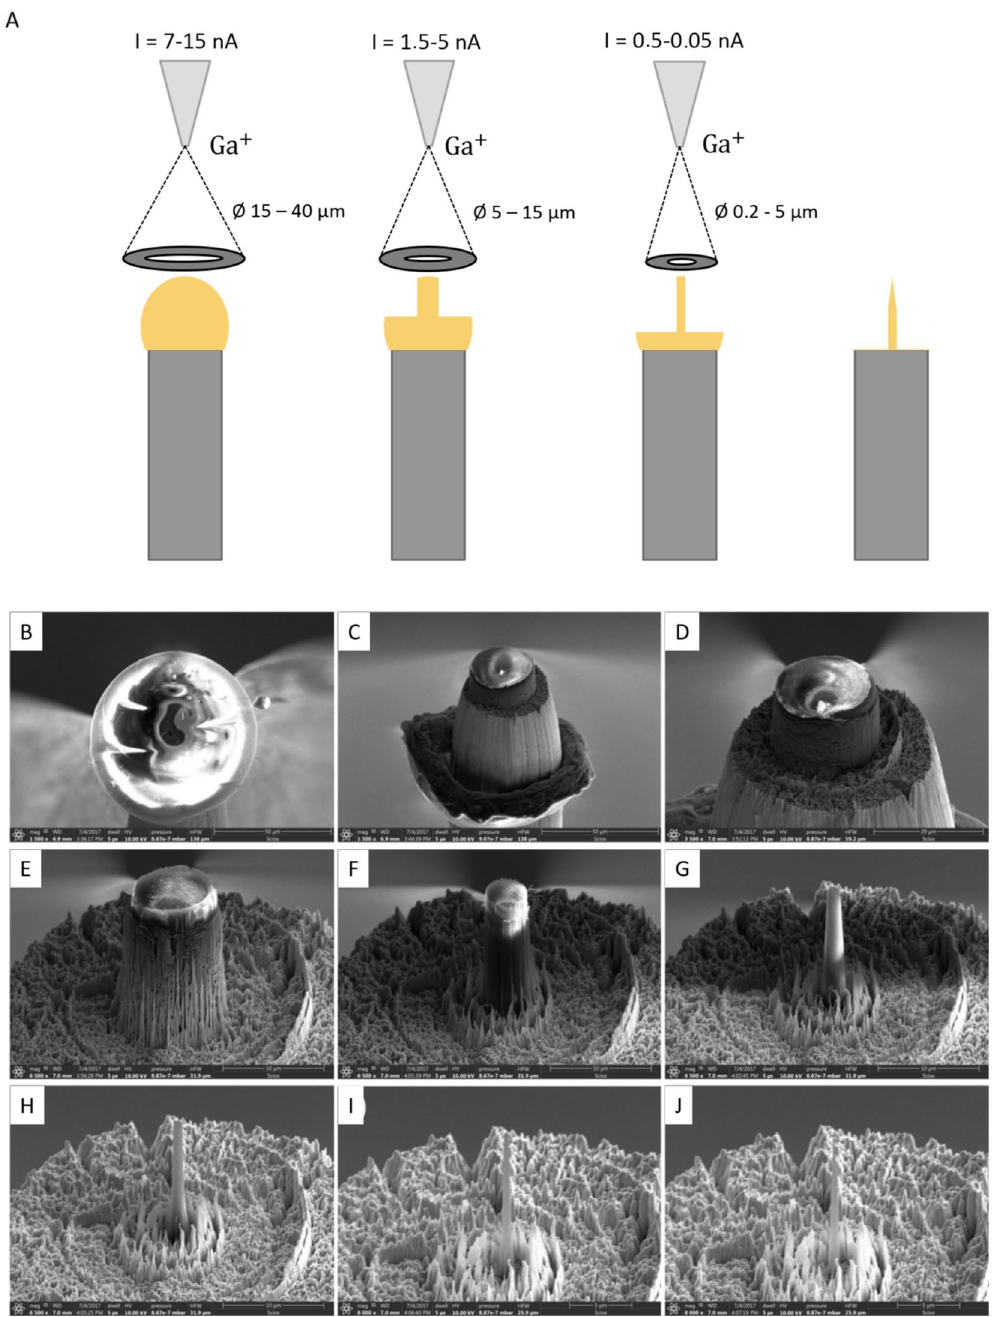
Figure 9. FIB Preparation—above in ( A ) the annular milling process with a decreasing inner diameter and respective current is schematically shown. ( B ) Frozen honey droplet on top of the tungsten post. ( A – I ) show the milling process with an annular pattern and decreasing inner diameter until a final tip with a radius < 100– 200 nm ( J ) is